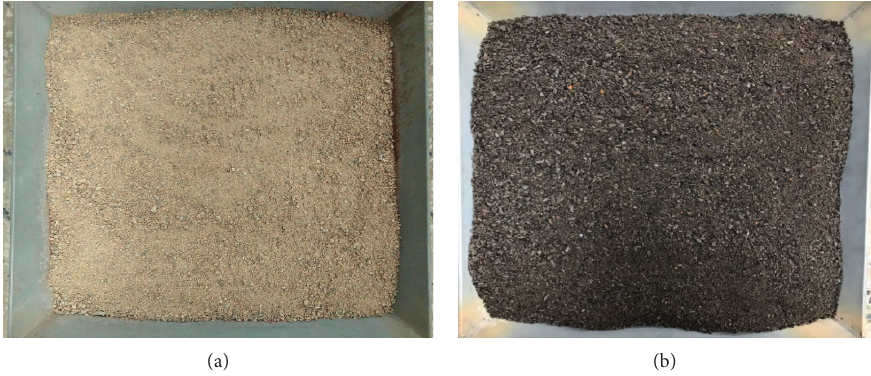
Figure 1: Natural fine aggregates and CBA aggregates. (a) Natural fine aggregates. (b) CBA aggregates.